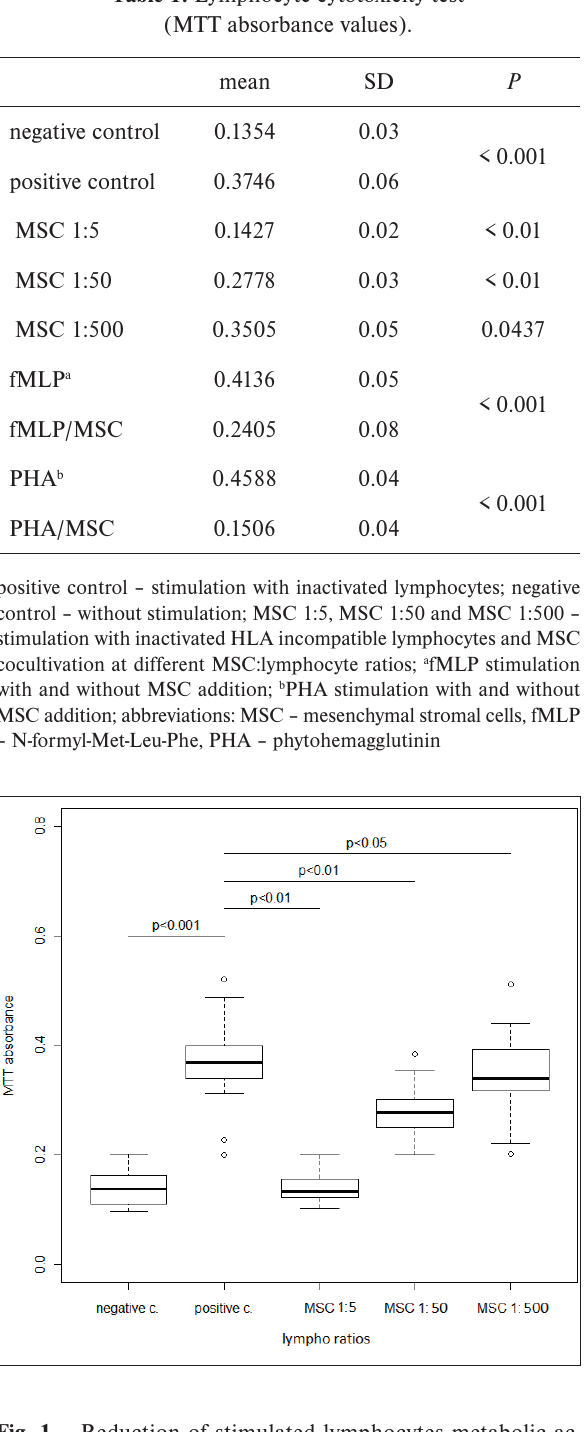
Fig. 1. Reduction of stimulated lymphocytes metabolic ac- tivity after MSC addition (stimulation with alloantigens). The cocultivation with MSC reduces the metabolic activity of stimu- lated lymphocytes in comparison to positive control (no MSC added). The MSC effect is dose dependent and higher MSC di- lutions are less effective in lymphocyte suppression. See details in the text. MTT absorbance values showed, Wilcoxon pair test (median; box: 25%, 75% quantiles; non-outlier min, non-outlier